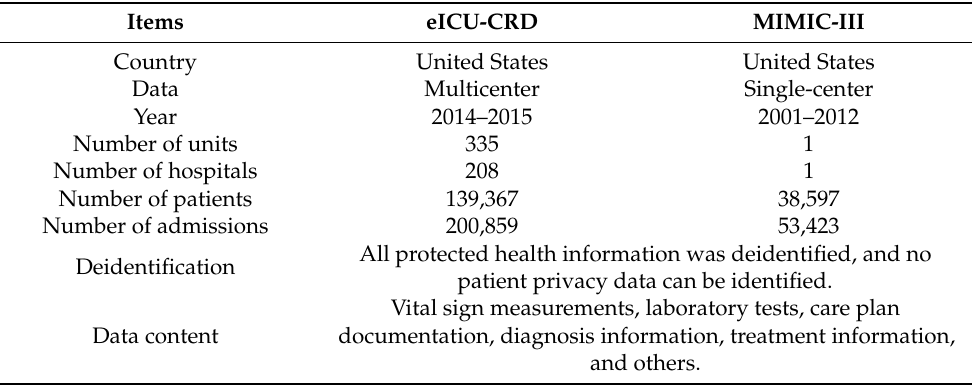
Table 2. Characteristics of eICU-CRD and